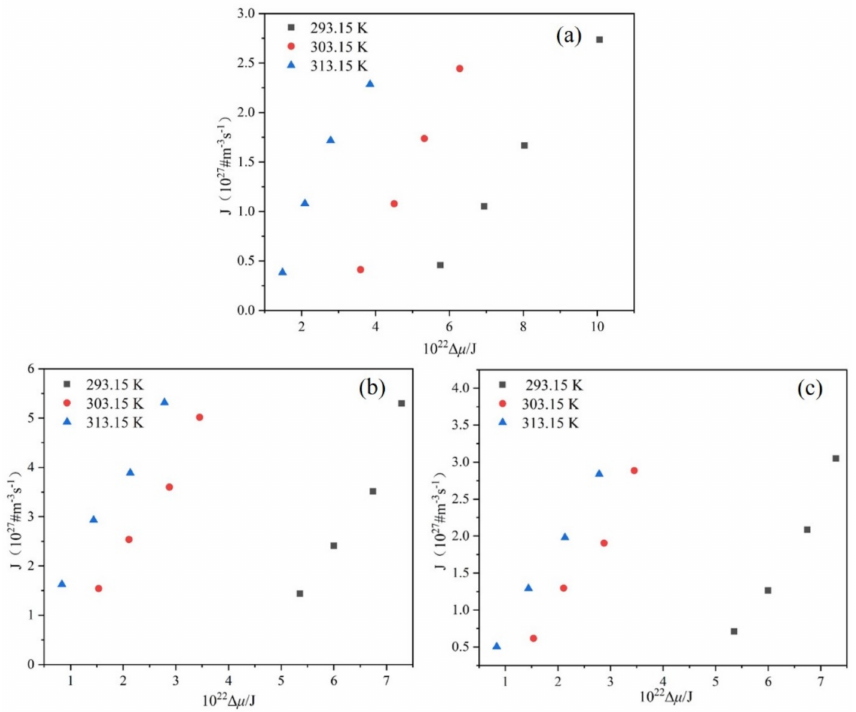
Figure 12. Relationship between J and ∆ µ at different T 0 : ( a ) ethanol mass fraction of 0.6, ( b ) ethanol mass fraction of 0.8, ( c ) ethanol mass fraction of